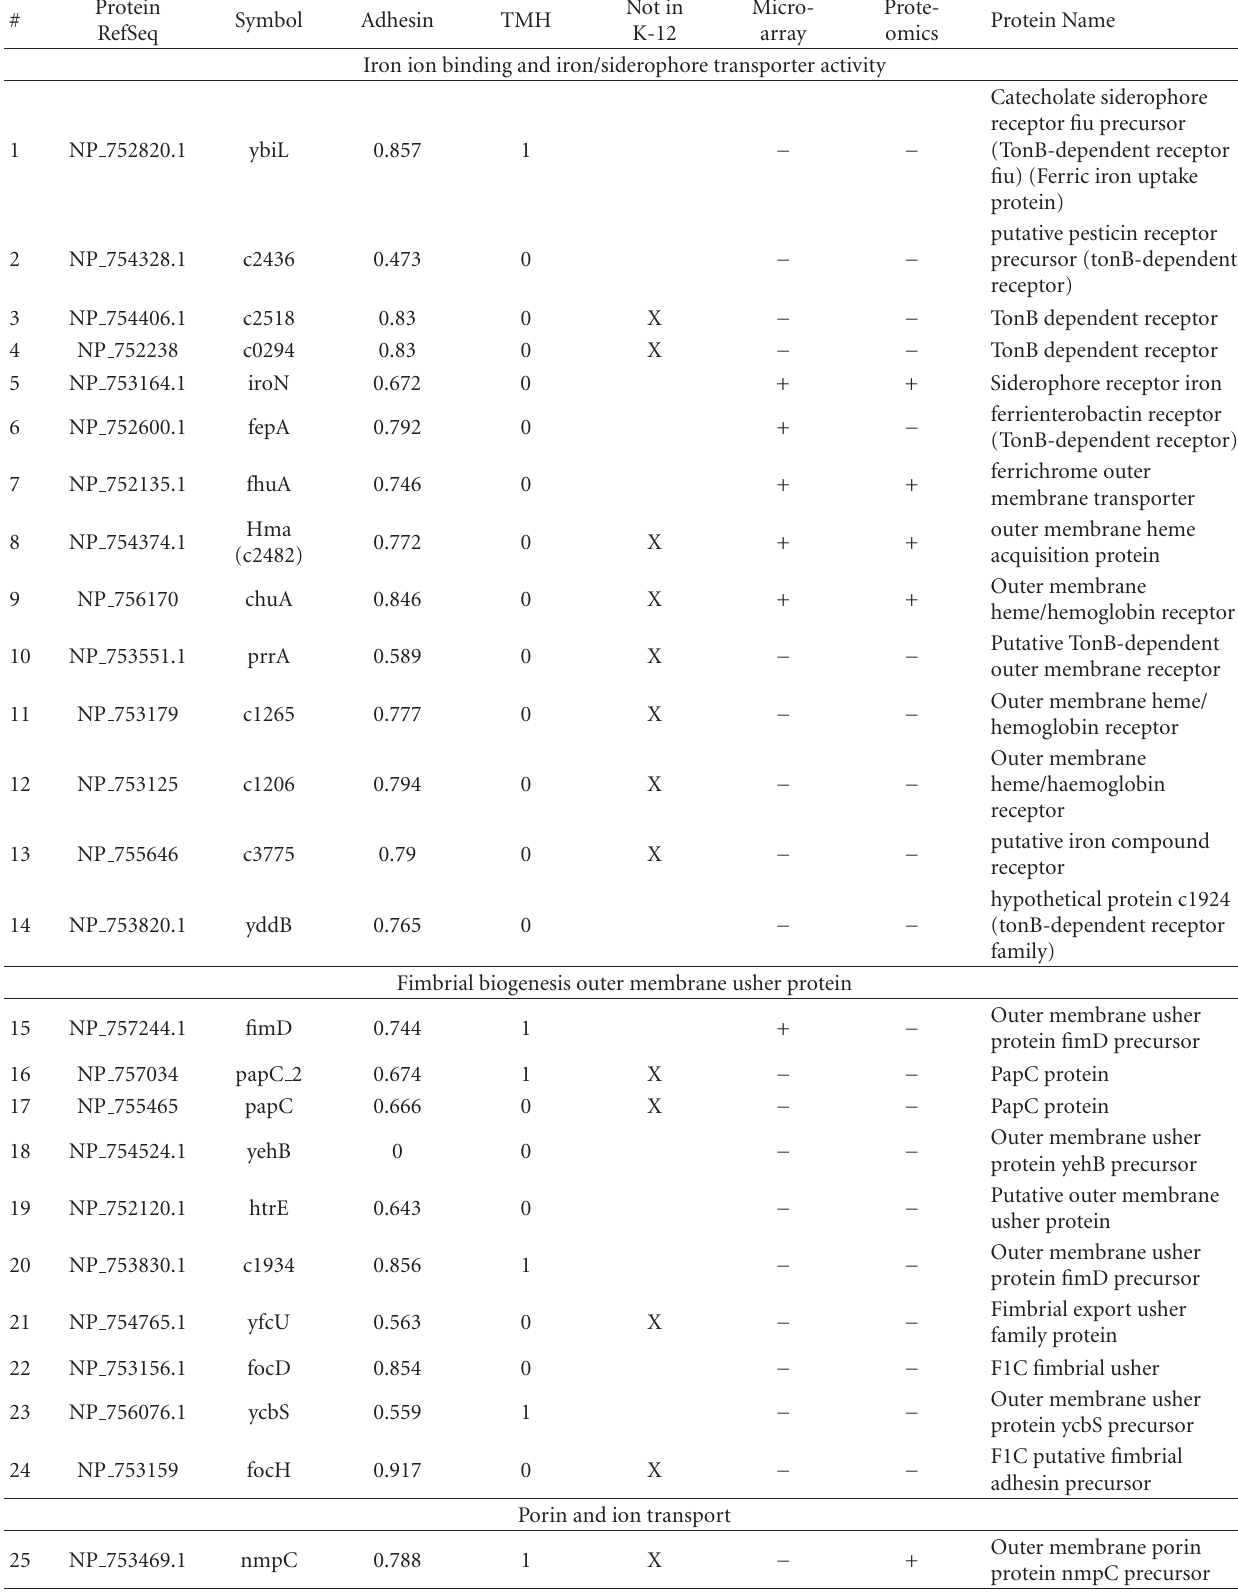
Table 4: Conserved UPEC outer membrane proteins predicted by